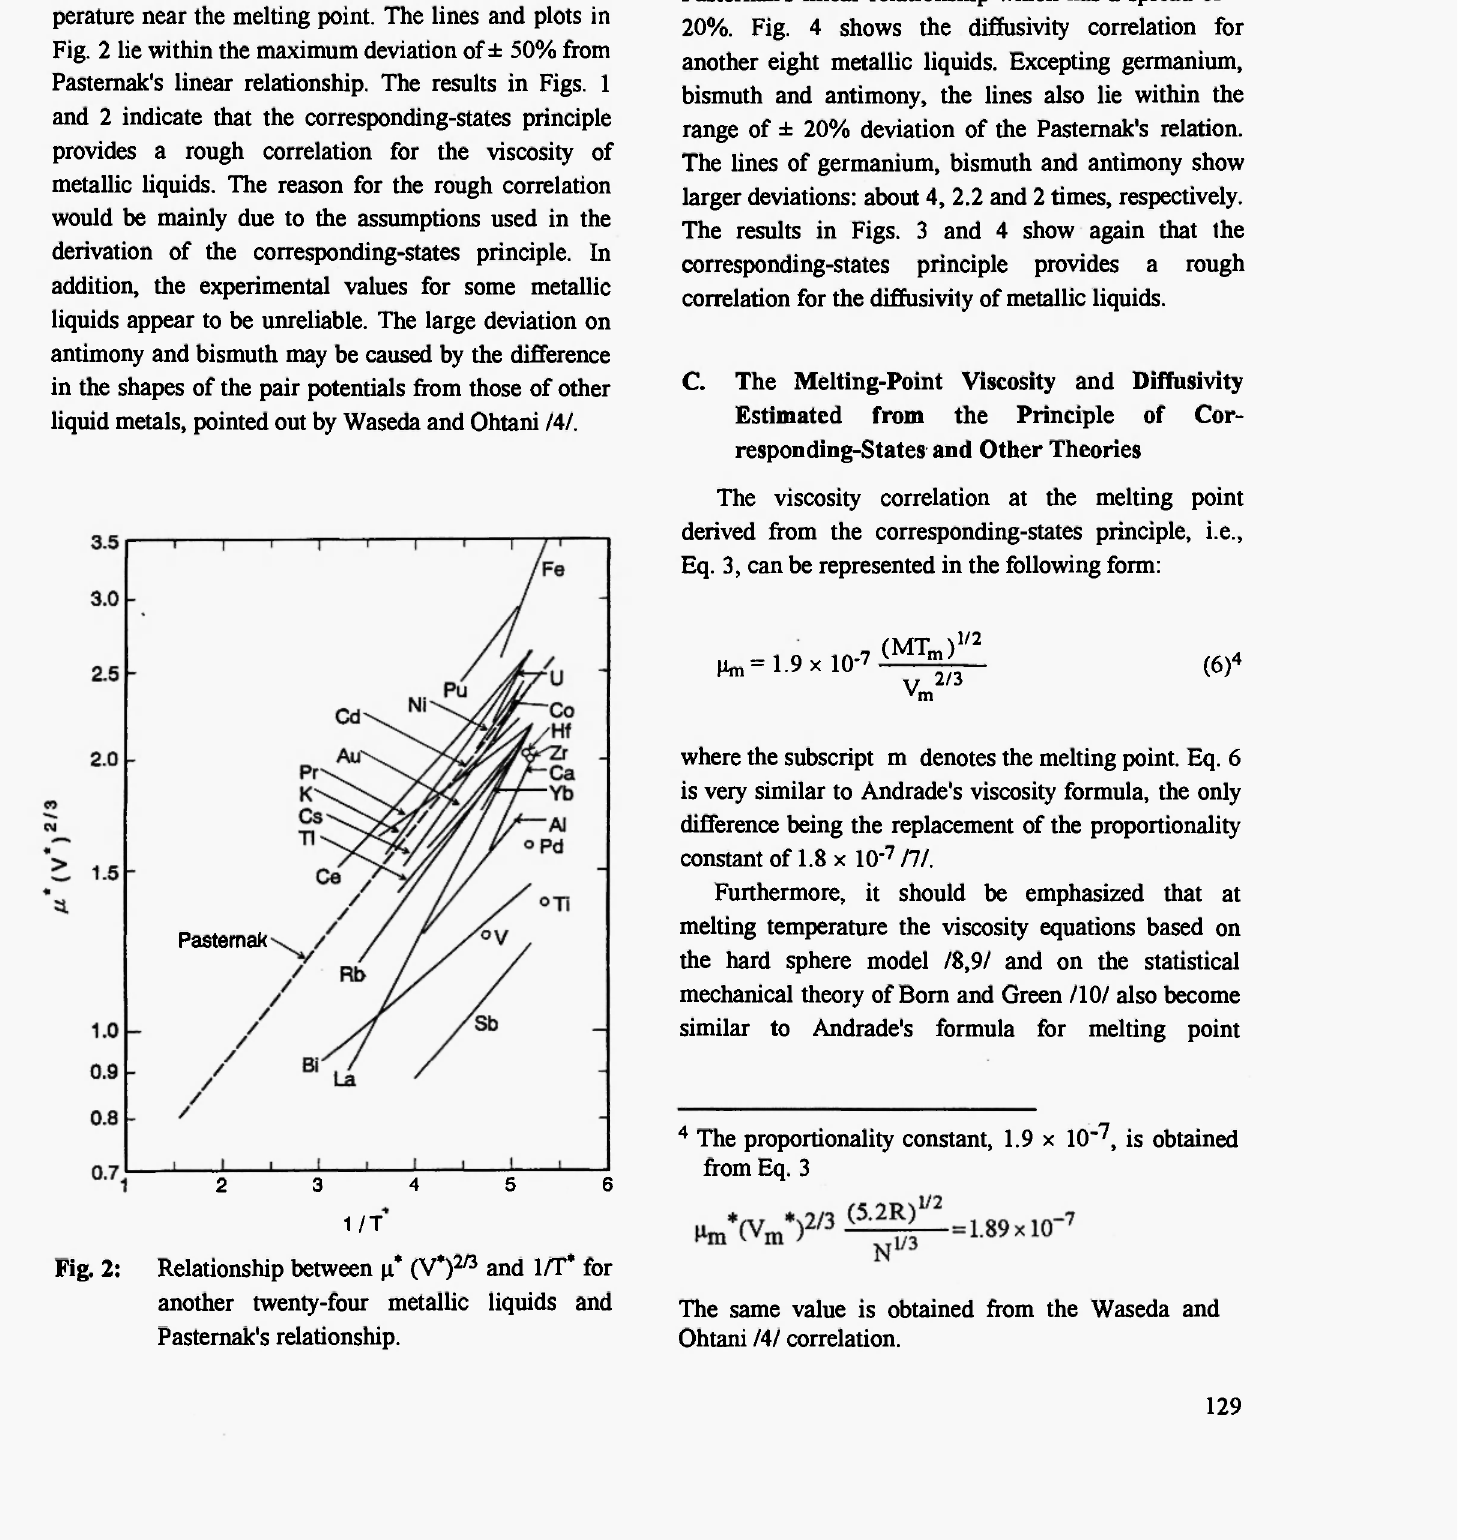
Fig. 2: Relationship between μ* (V*) 2/3 and 1/T* for another twenty-four metallic liquids and Pasternak's